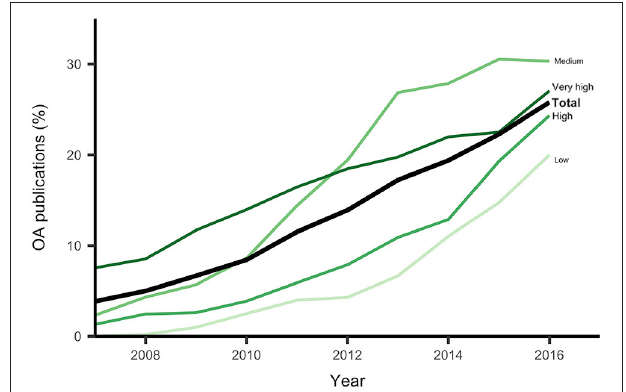
FIGURE 1 | Increasing prevalence of open access (OA) climate studies published between 2007 and 2016. Proportional increase in OA climate change publications (black line) and across four journal ranking categories (colored lines; low = 0.14–0.93, medium = 0.93–1.5, high = 1.5–2.2, very high = 2.2–18.1). Publications were extracted from Scopus (www.scopus. com) for articles and reviews published between 2007 and 2016